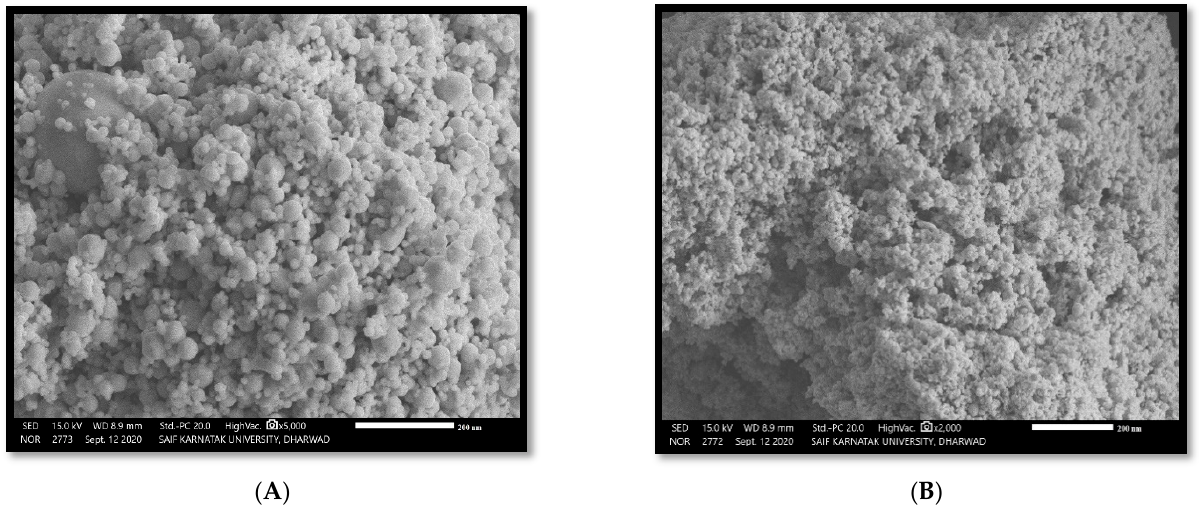
Figure 4. ( A ) SEM image of A. indica -based AgNPs at 61.70 nm. ( B ) SEM image of P. pinnata AgNPs at 68.80 nm. Table 1. Toxicity of green AgNPs. Synthesized from leaves of Azadirachta indica on larval mortality of H. armigera (Instar 2).